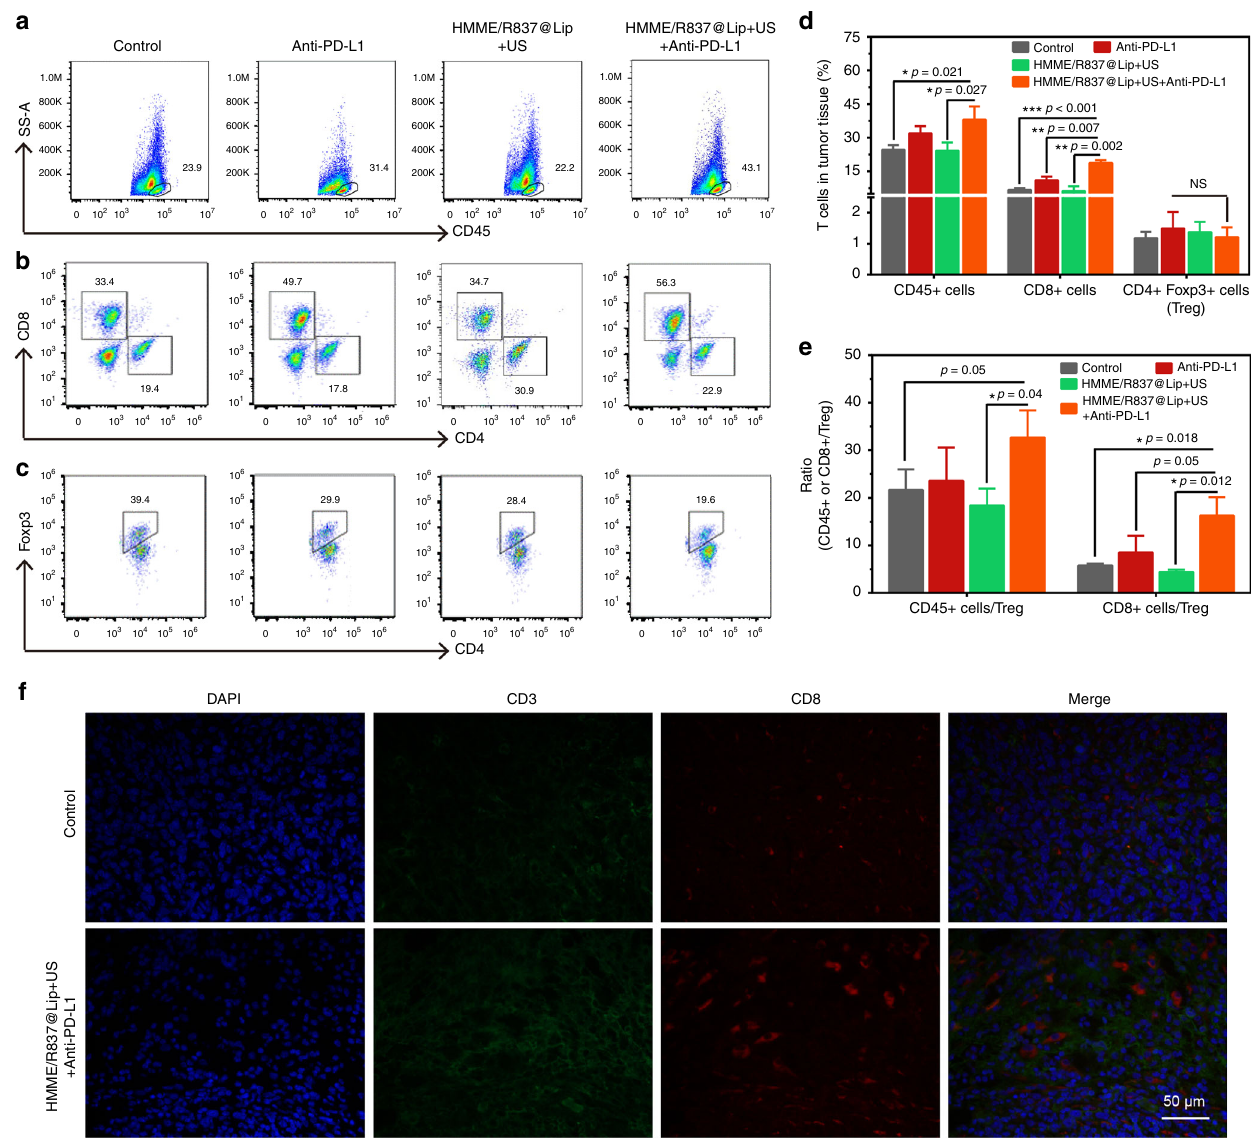
Fig. 7 HMME/R837@Lip-augmented SDT plus anti-PD-L1 therapy activating systematic antitumour immunity. a – c Representative fl ow-cytometry plots showing the tumour-in fi ltrating leucocyte cells, including CD45 + cells (CD45 + ), CD8 + T cells (CD45 + CD3e + CD8 + ) and CD4 + FoxP3 + T cells (CD45 + CD3e + CD4 + FoxP3 + ) in mimic distant tumours; d absolute quanti fi cation of the CD45 + cells, CD8 + T cells and CD4 + FoxP3 + regulatory T cells (Treg) in mimic distant tumours (gating on CD3 + cells), error bars are based on SD ( n = 3); e CD45 + cells: Treg ratios and CD8 + cells: Treg ratios in the distant tumours after various treatments to remove the fi rst tumour. Values are mean ± SD ( n = 3); f representative CLSM images of the mimic distant tumours after immuno fl uorescence staining (scale bar = 50 μ m). Statistical signi fi cances were calculated via Student ’ s t test or Mann – Whitney U test. NS not signi fi cant. * p < 0.05, ** p < 0.01 and *** p <